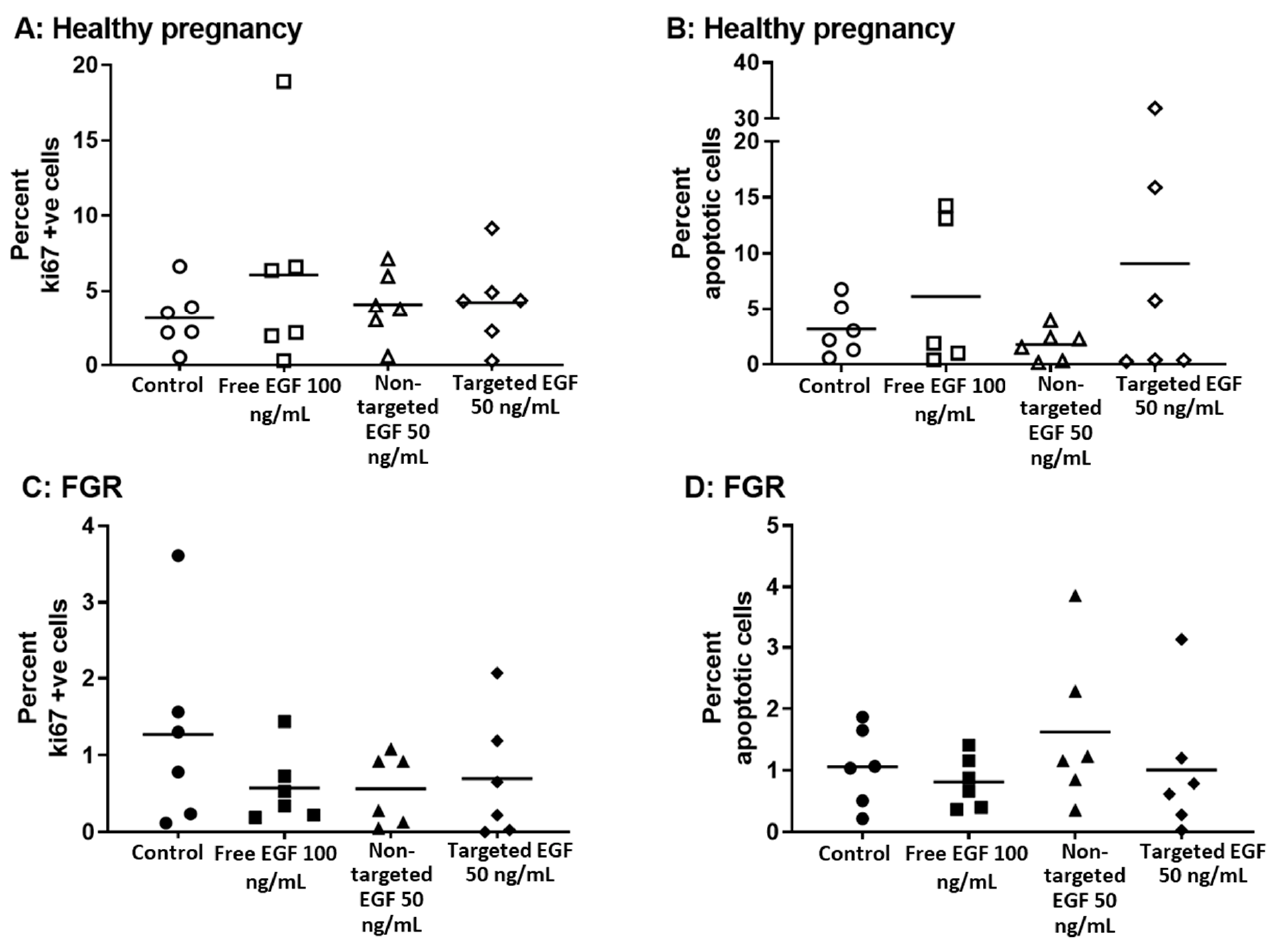
Figure 4. Targeted delivery of EGF does not alter the percentage of placental cells in cycle or undergoing apoptosis in healthy pregnancy or FGR. Healthy ( A , B ) and FGR ( C , D ) third-trimester human placental explants were cultured for 7 days and treated with either 10 µL PBS (control), free EGF (100 ng/mL), undecorated liposomes encapsulating 50 ng/mL EGF (non-targeted) or GPS-decorated liposomes encapsulating 50 ng/mL EGF (targeted) for 48 h on days 5–7. Percent of M30-positive ( B,D ) and Ki67-positive ( A,C ) apoptotic and cells in cycle, respectively. Mean, n = 5–6 placentas. Data not significantly different. EGF = epidermal growth factor, FGR = fetal growth restriction.